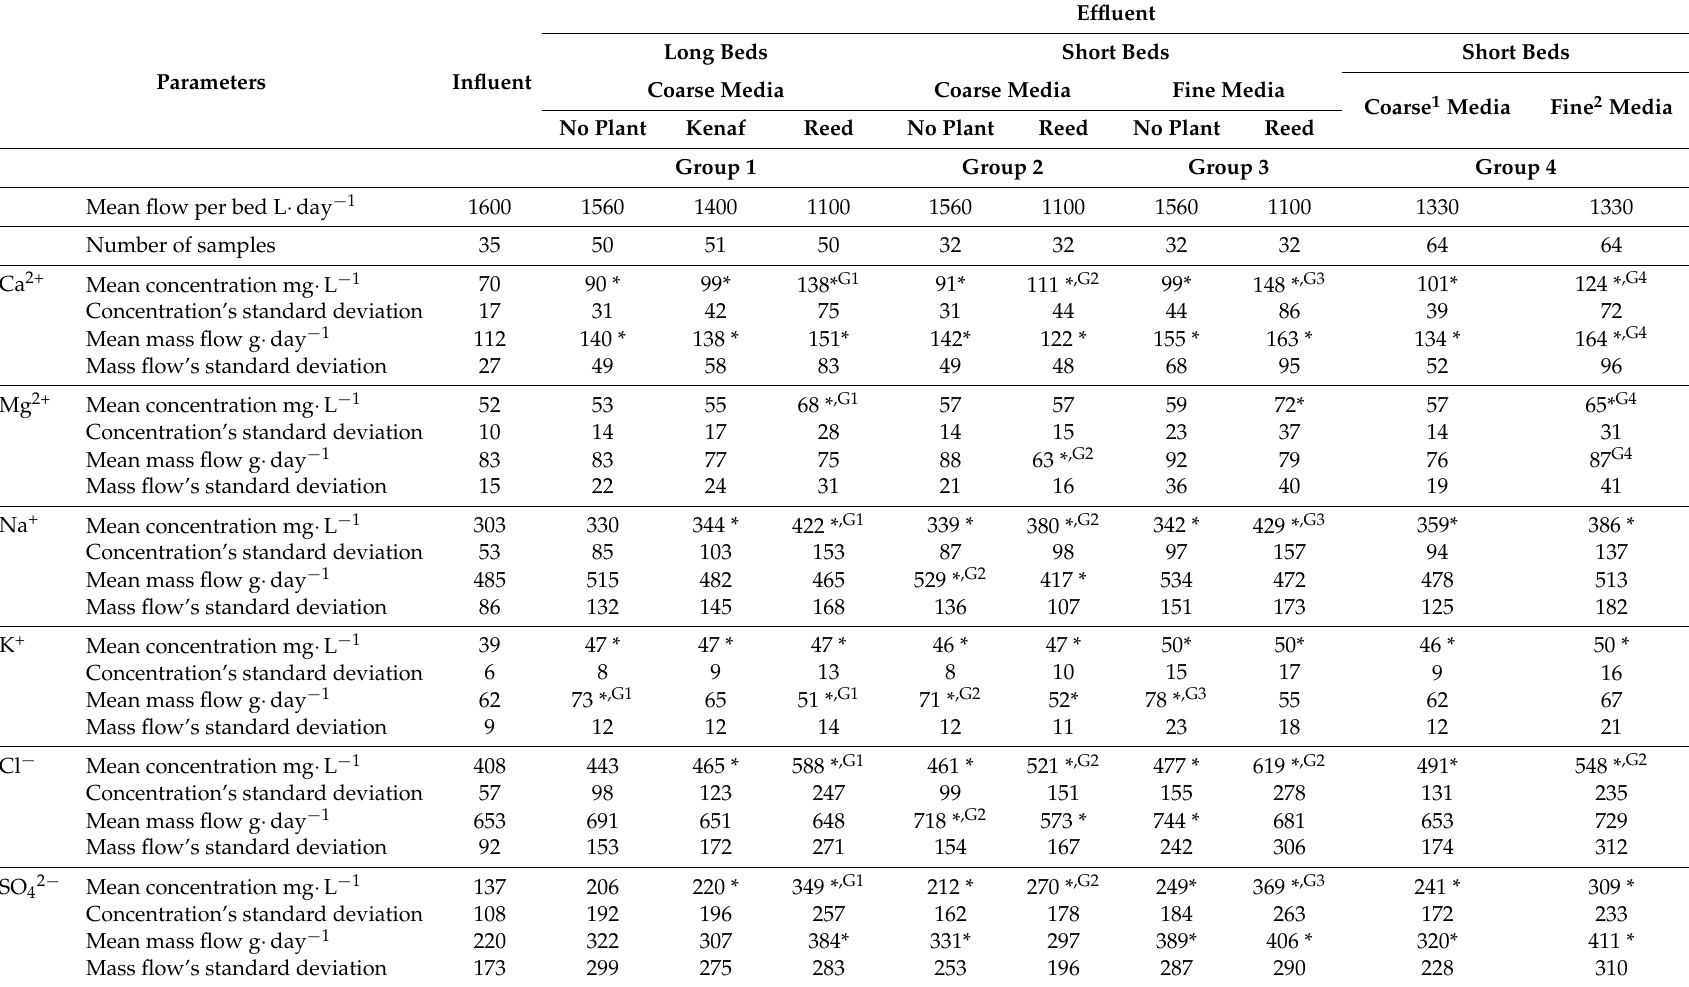
Table A2. Major anions, cations, micronutrients, and heavy metals in the influent and treated effluents.